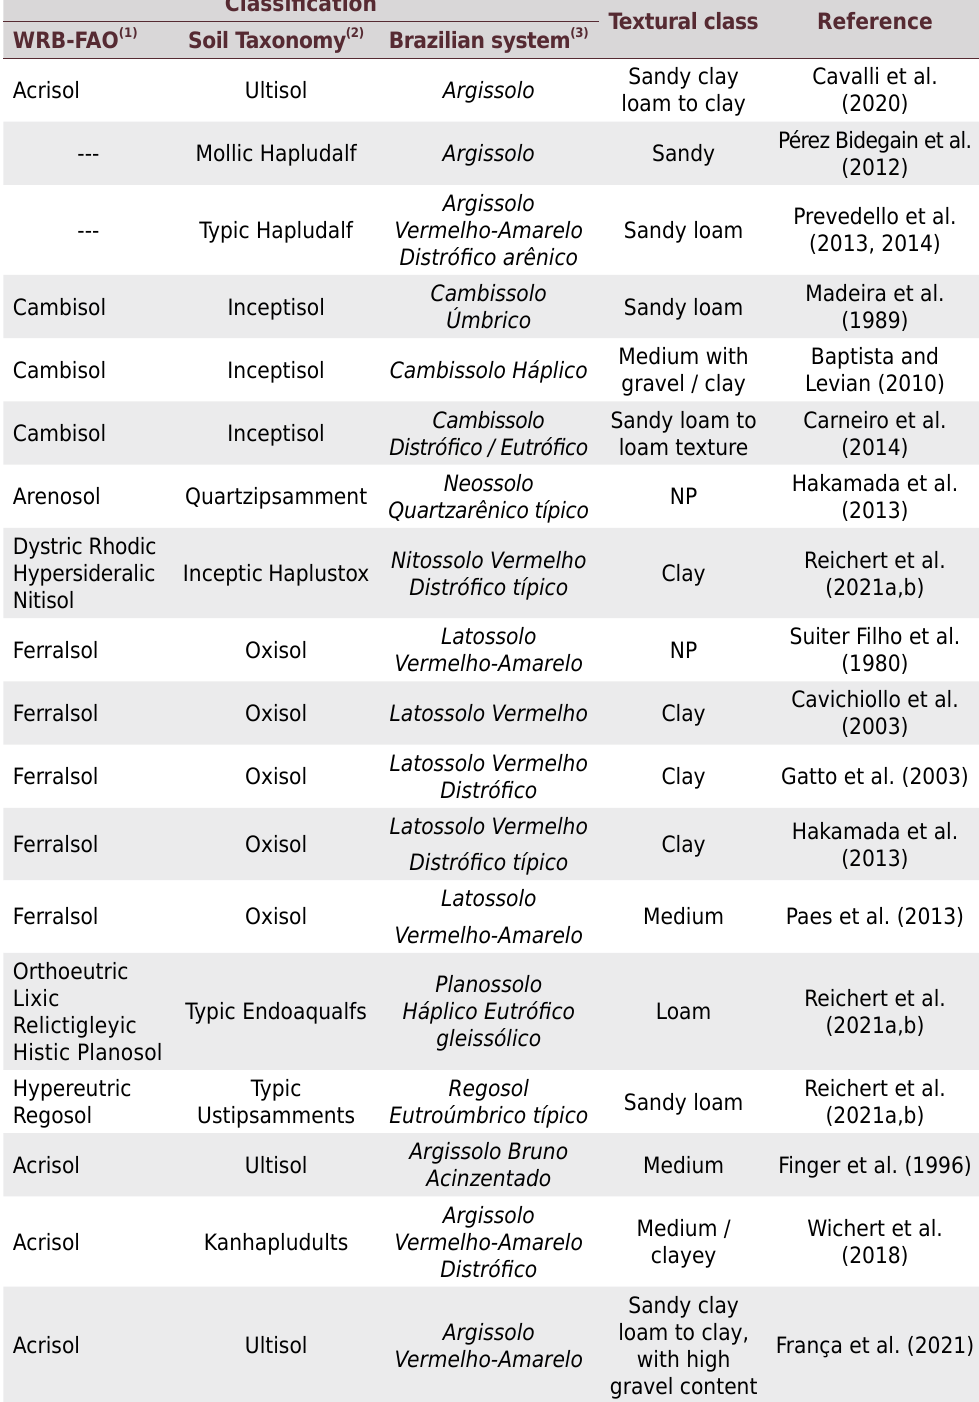
Table 1. Soil classification and soil texture of referenced